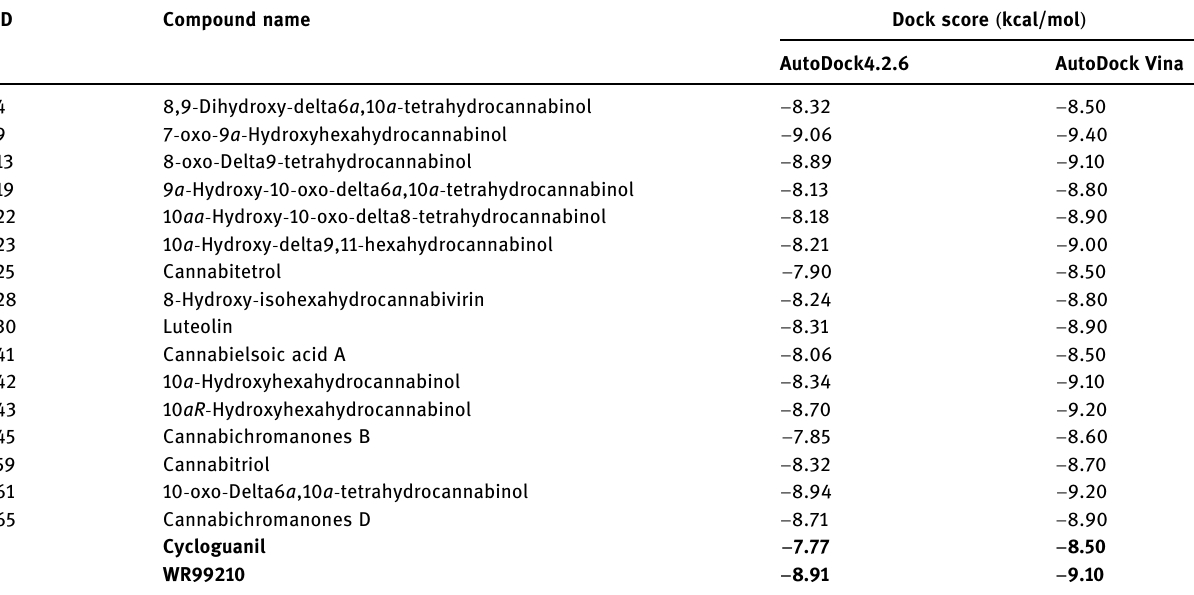
The bold rows indicate data for standard